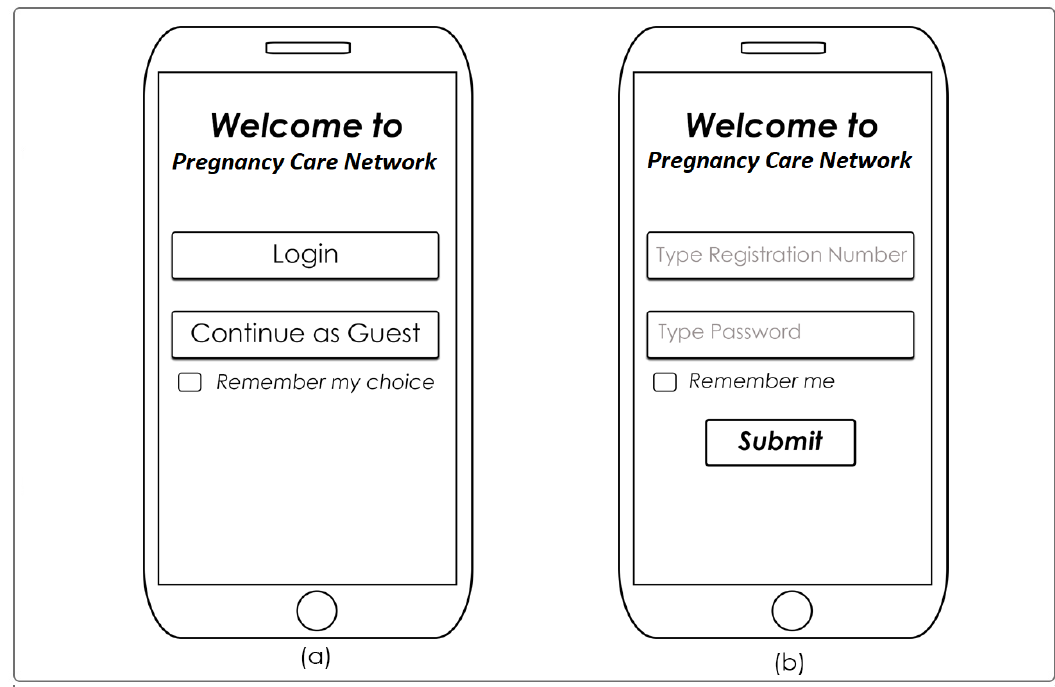
Figure 4. ( a ) shows the welcome screen of the client app. ( b ) shows the login screen for registered women.